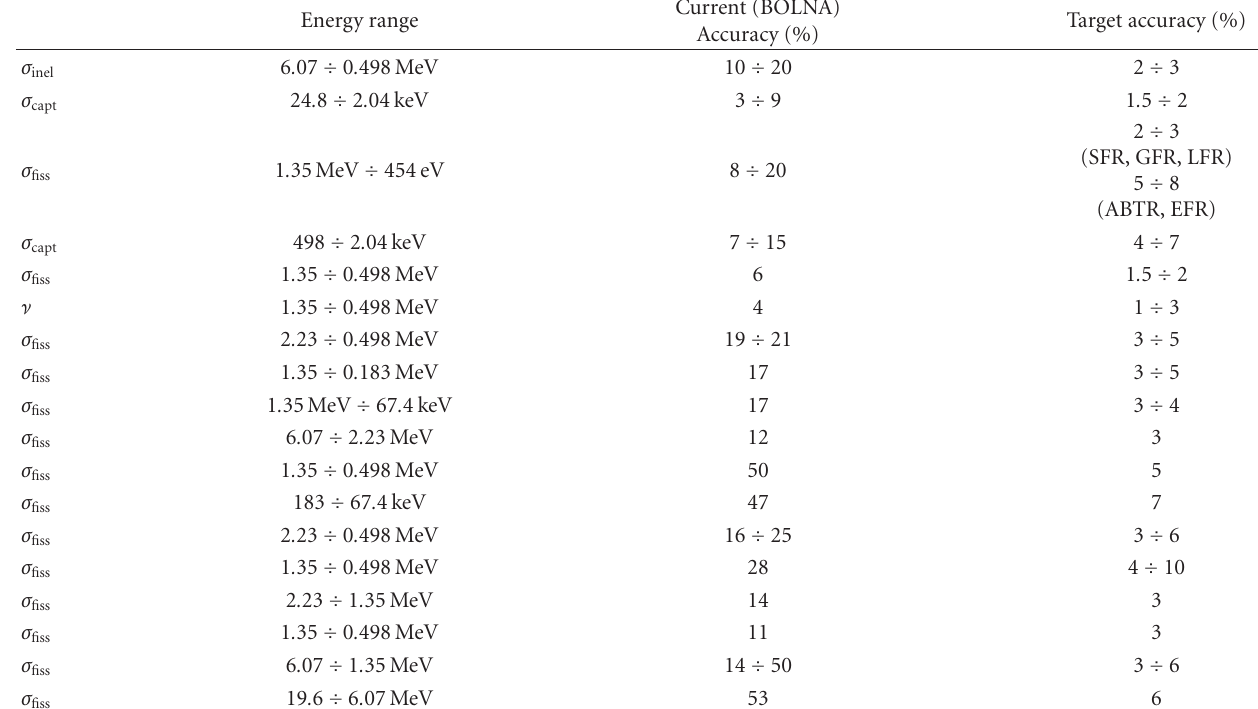
Table 1: Summary of highest-priority target accuracies for fast reactors from subgroup